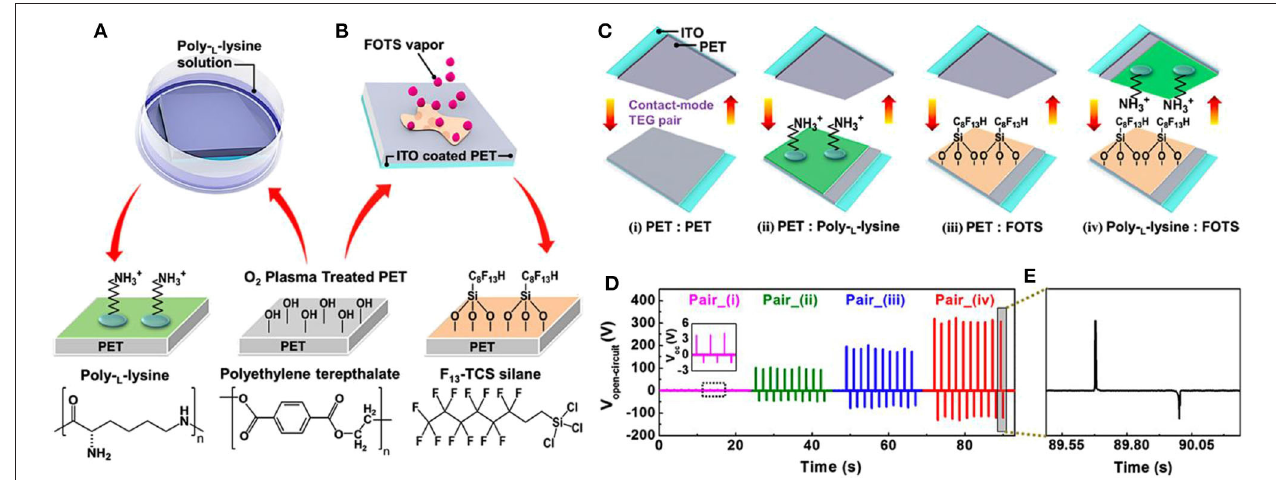
FIGURE 3 | Schematic illustration of modification processes and output performance of TENGs with functionalized-surfaces. (A) The surface modification process by dip-coating and (B) self-assembling deposition. (C) Schematic of TENGs fabricated with different contact pairs. (D) Open-circuit voltage of corresponding TENGs. (E) Local enlarged peaks of the open-circuit voltage. Reprinted with permission from Shin and Kwon (2015). Copyright 2015 American Chemical Society.